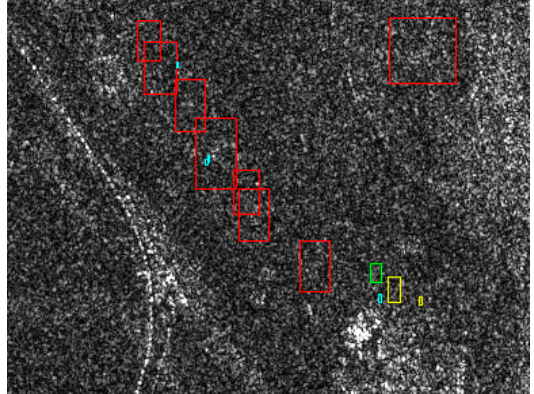
Figure 9. Cluster of Saka kurgans in the TSX SM image from 5 June 2014 (SAR image © DLR, 2015). ( Saka kurgans = red, Scythian kurgans = green rectangle, ogradkas = purple, undatable mounds = yellow, and all other objects = cyan).